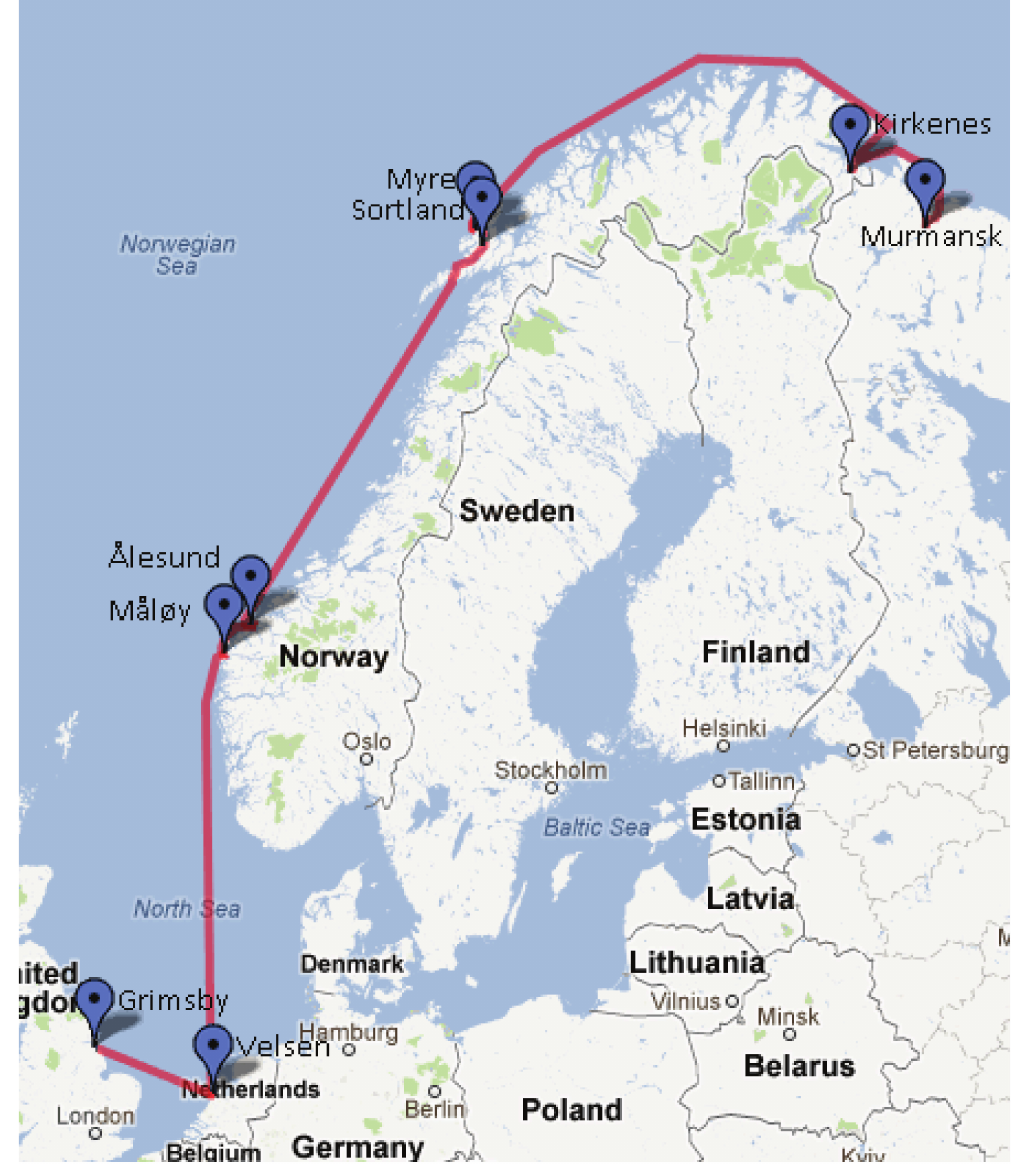
Figure 1: Vessel route from Murmansk to